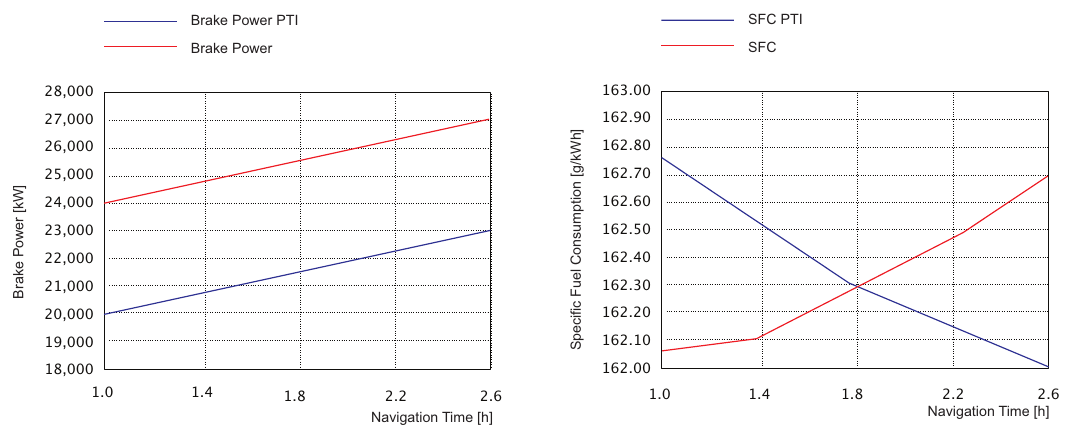
Figure 11. PTI evaluation performance.